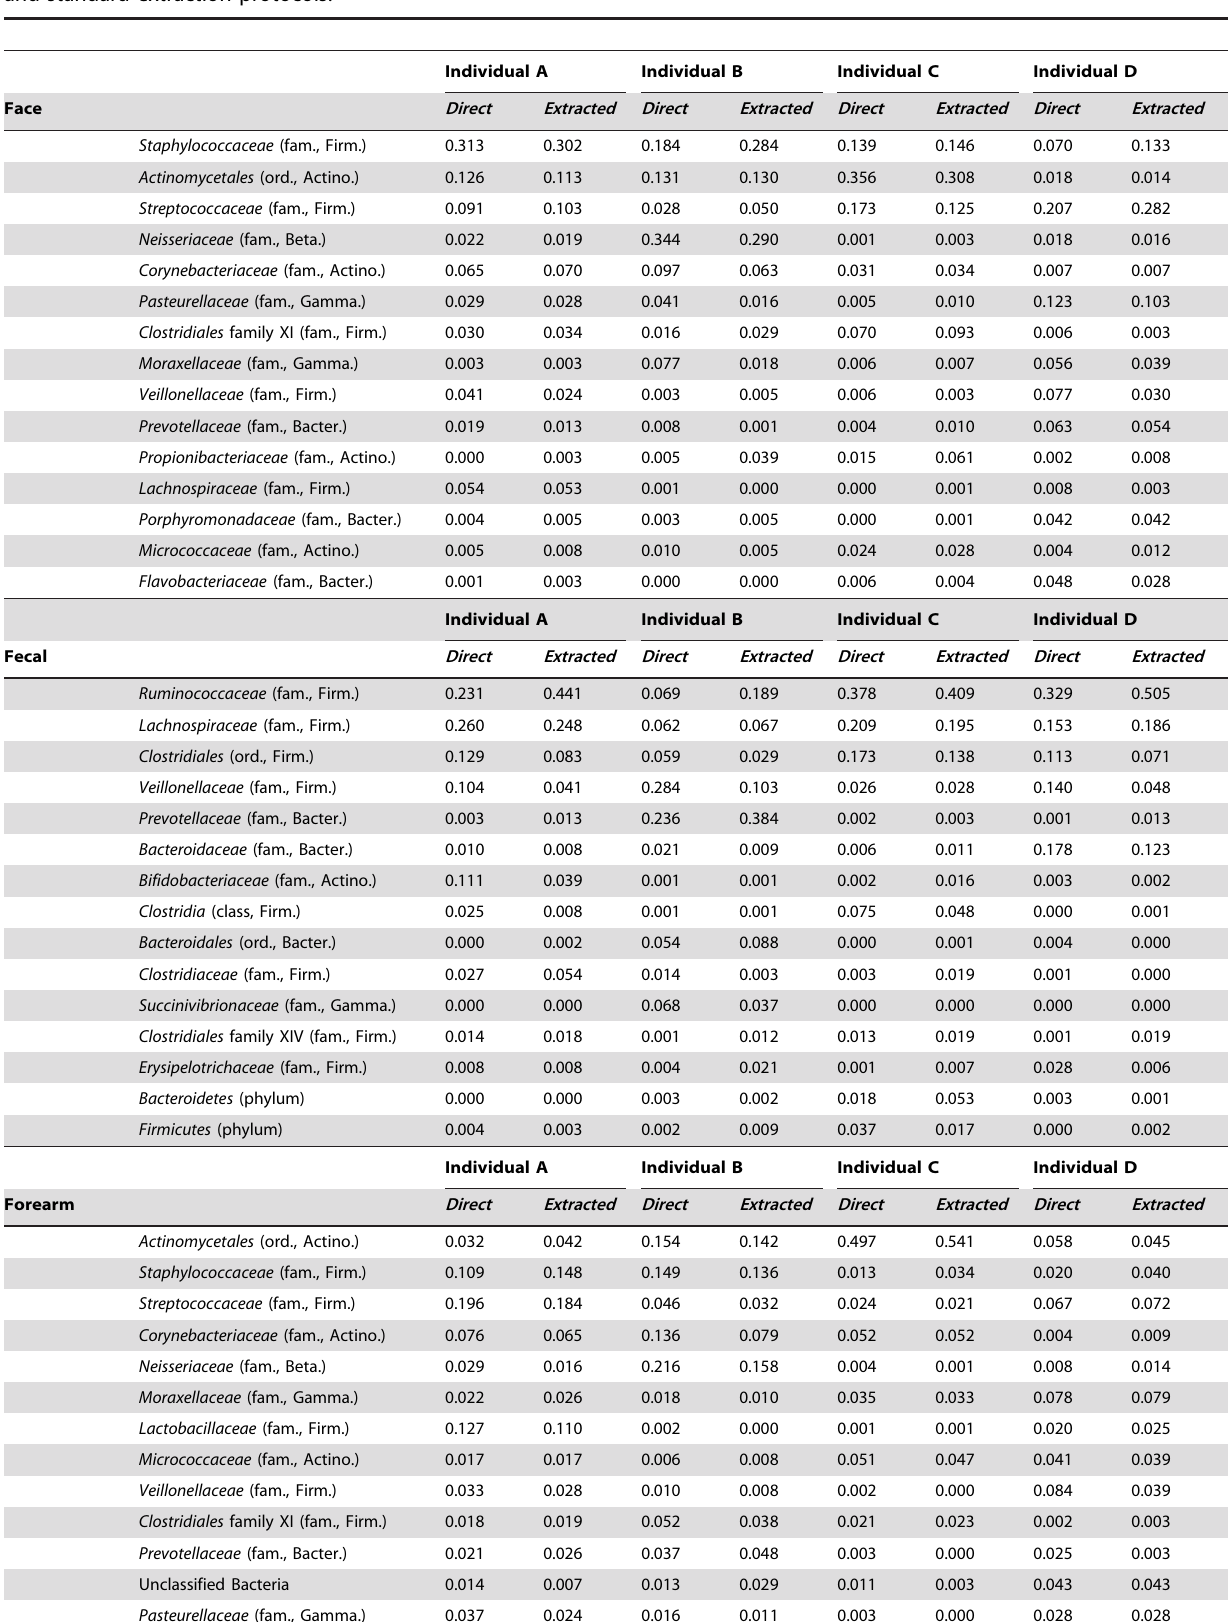
Table 1. Average abundance of top 15 taxonomic groups of each body habitat from each individual observed with the direct PCR and standard extraction protocols.